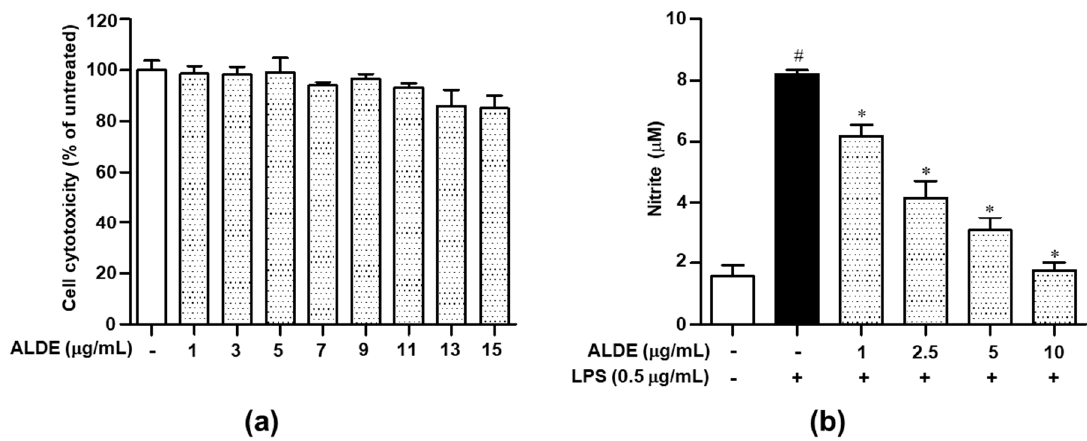
Figure 2. E ff ects of ALDE on cell viability and NO production in RAW 264.7 cells. ( a ) RAW 264.7 cells were treated with various concentrations of ALDE for 24 h. Subsequently, cell viability was measured using the EZ-Cytox reagent and compared with that in the untreated group. ( b ) RAW 264.7 cells were treated with LPS (0.5 µ g / mL) in the presence of ALDE (1, 2.5, 5, and 10 µ g / mL) for 24 h. Subsequently, NO production in the culture supernatant was measured using a Griess assay. NO secretion was calculated using a standard curve of concentrations of nitrite standard solution. The data presented are the mean ± SEM of three independent experiments. Di ff erences between groups were analyzed using the Mann–Whitney U test. # p < 0.05 vs. LPS-untreated control groups; ∗ p < 0.05 vs. LPS-treated groups. ALDE: Ethanol extract of Aucklandia lappa Decne.; LPS: Lipopolysaccharide; NO: Nitric oxide.